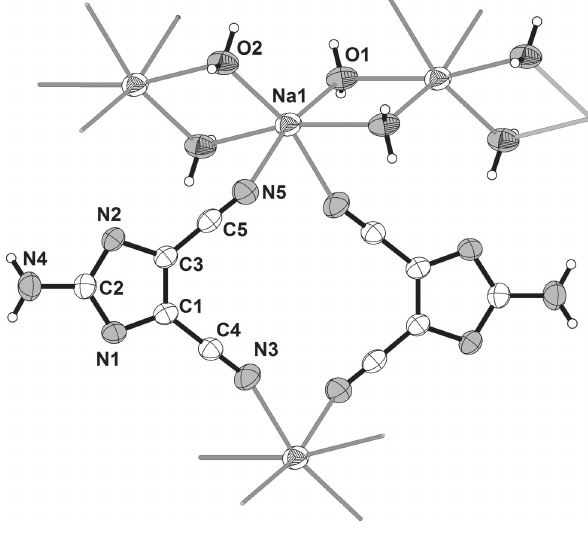
Table 1: Data collection and handling.